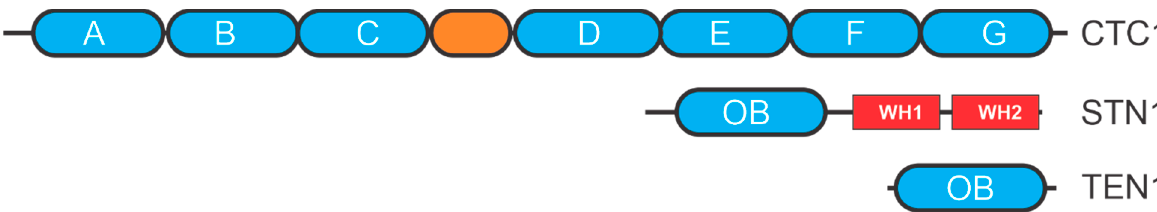
Figure 3. CST structural motifs. OB-folds are depicted as ovals with other motifs depicted as rectangles. WH is a winged-helix motif.